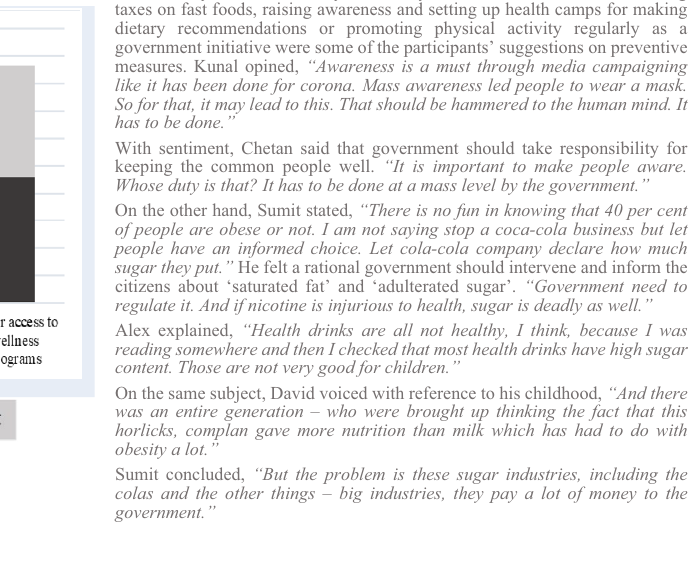
Quantitative survey